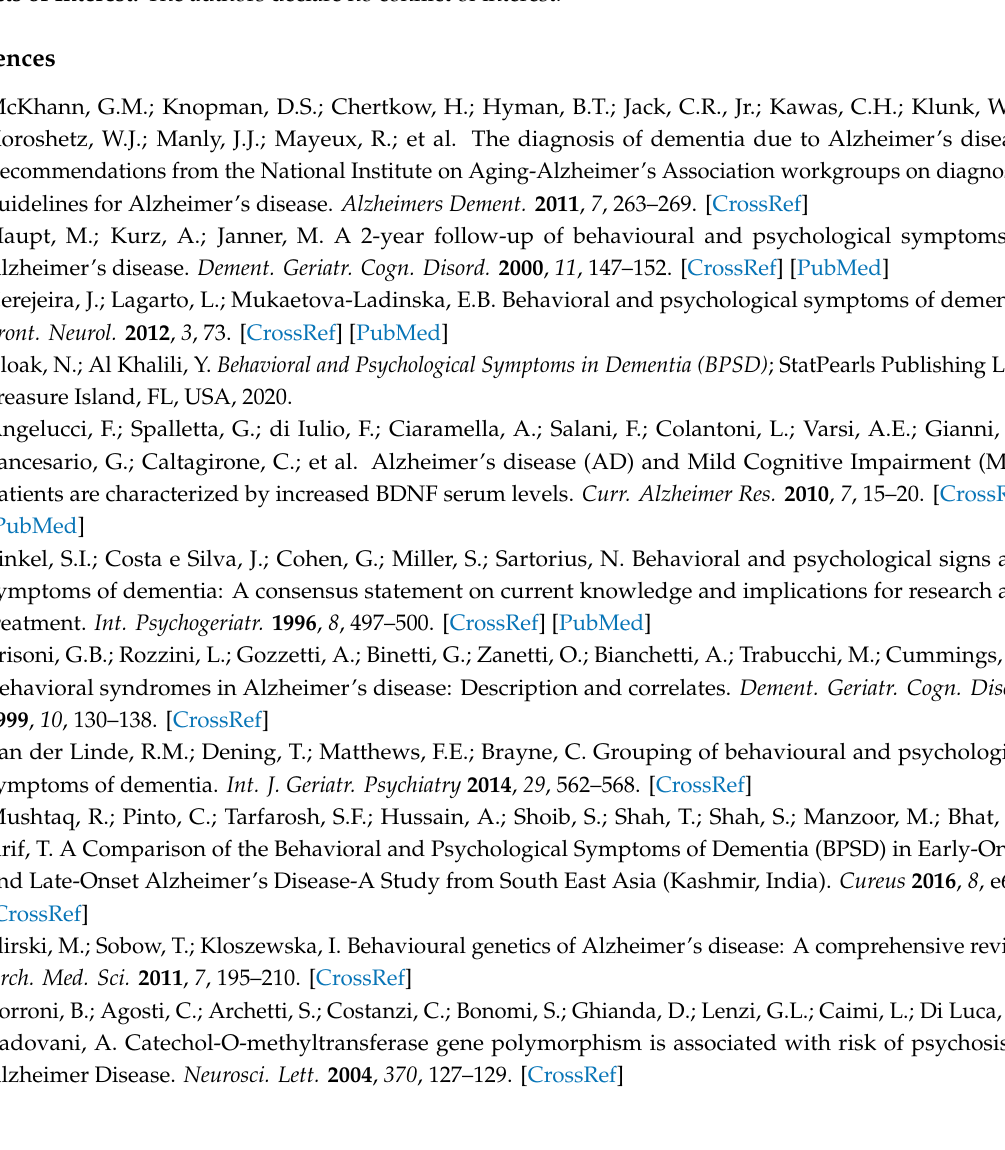
Table S1: Univariate Analysis of Variance in our BPSD cohort: Tests of Between-Subjects E ff ects for Gender variable and BPSD endophenotypes, Table S2: Univariate Analysis of Variance in our BPSD cohort: Tests of Between-Subjects E ff ects for Age variable and BPSD endophenotypes, Table S3: Hosmer-Lemeshow goodness of Table S5: Stepwise multiple logistic regression for “Hyperactivity” endophenotype, Figure S1: Exaustive CHAID data mining algorithm analysis results (“gene × gene” interaction) for single BPSD symptoms according to di ff erent values of